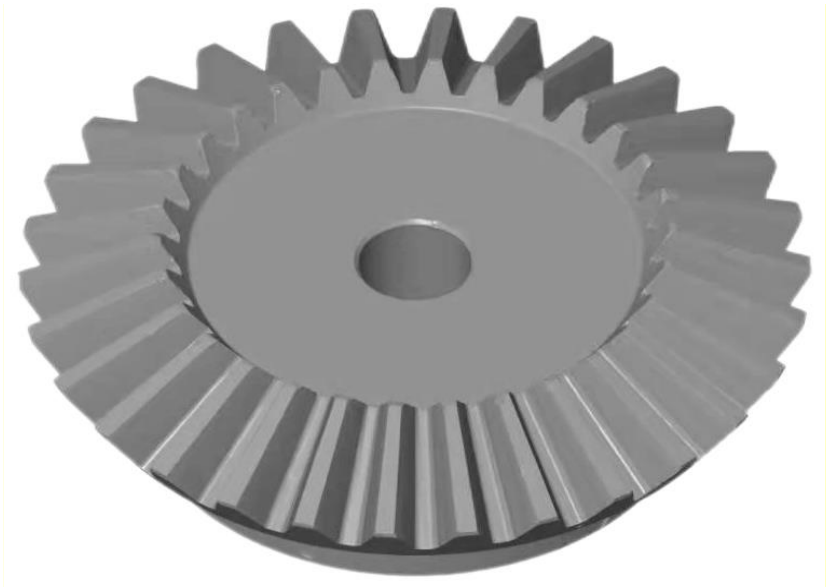
Figure 11. Preprocessed point clouds.